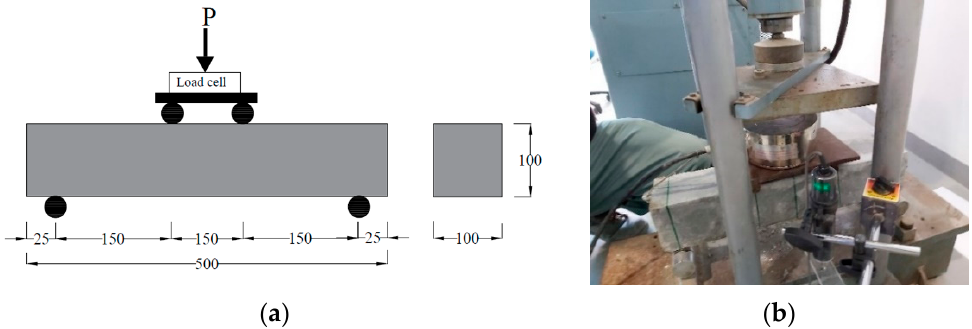
Figure 4. Four-point flexural test details: ( a ) a schematic diagram (dimensions are in mm); ( b ) a test in progress.